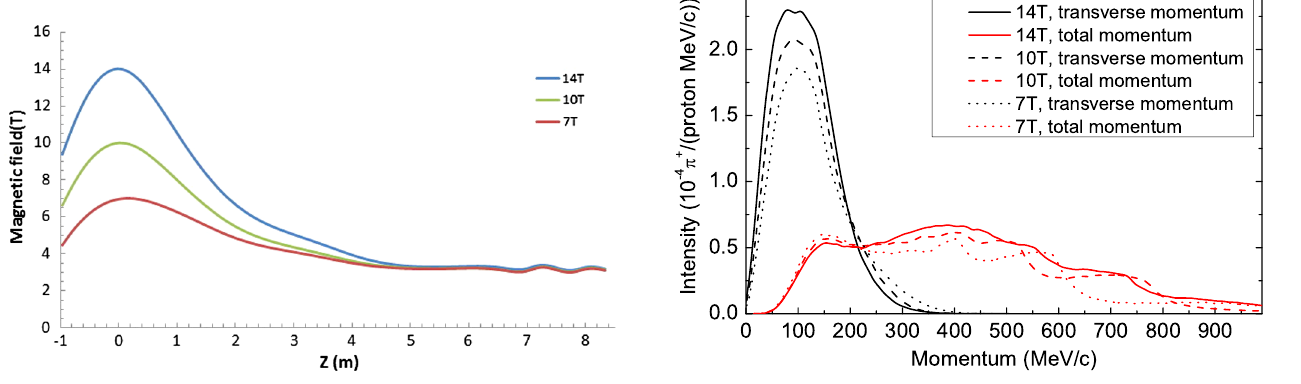
FIG. 10. Momentum spectrum of the extracted pions after field tapering with 7-T, 10-T and 14-T capture fields,